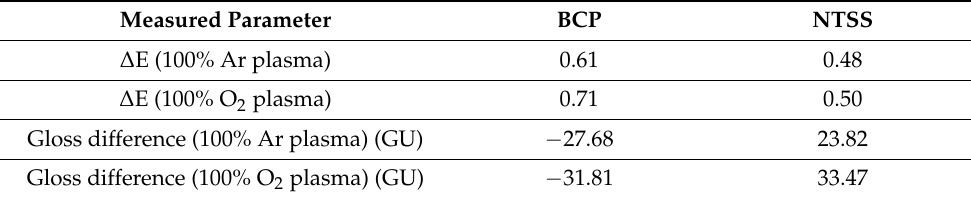
Table 5. Change in color and gloss of the film due to plasma